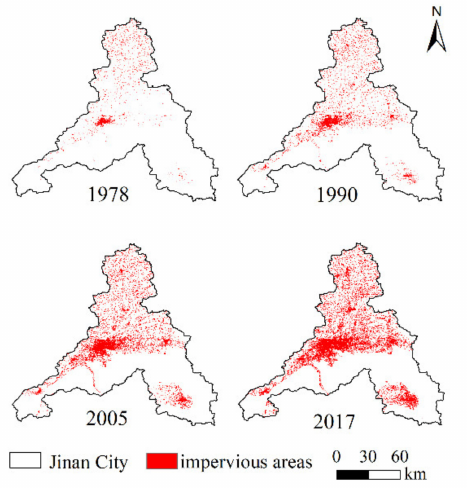
Figure 3. Spatial distribution of impervious surface areas in Jinan City during the period of 1978–2017.